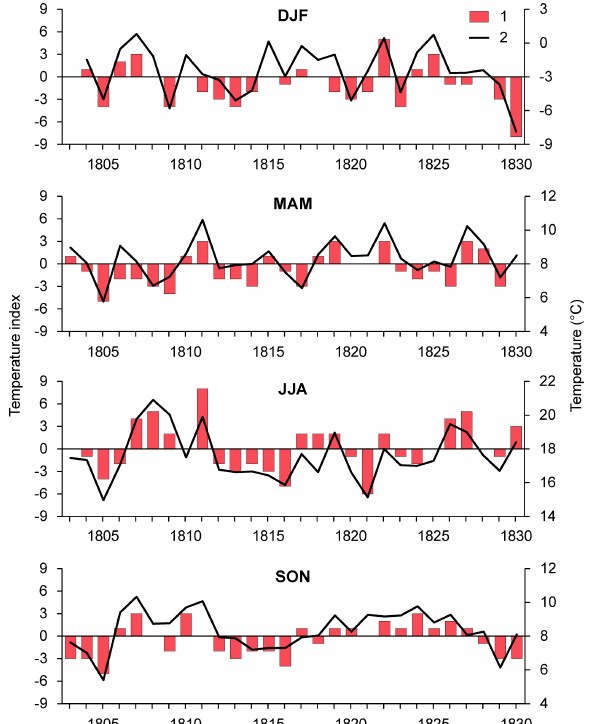
Figure 12. Fluctuations in weighted seasonal precipitation indices in Buchlovice (1) and in seasonal precipitation totals in Brno (2) during the 1803–1830